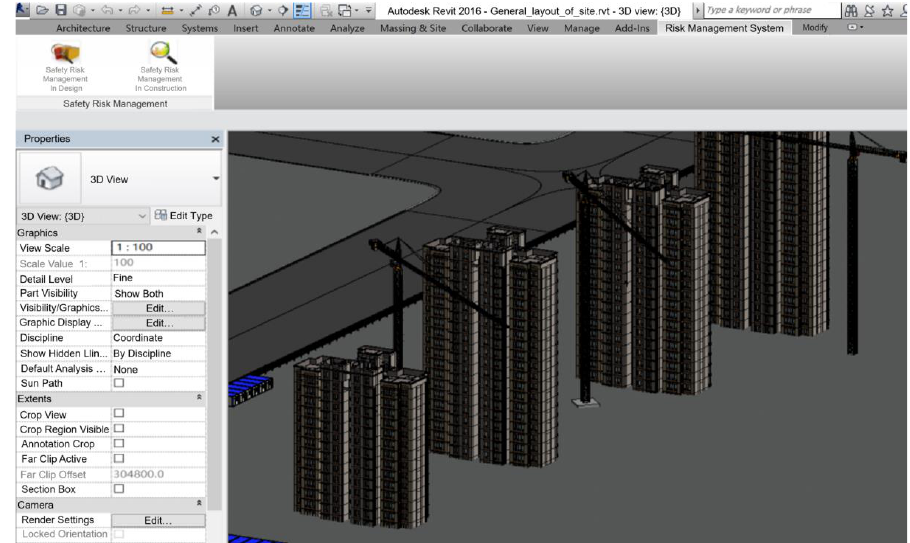
Figure 11. BIM model in the construction stage.